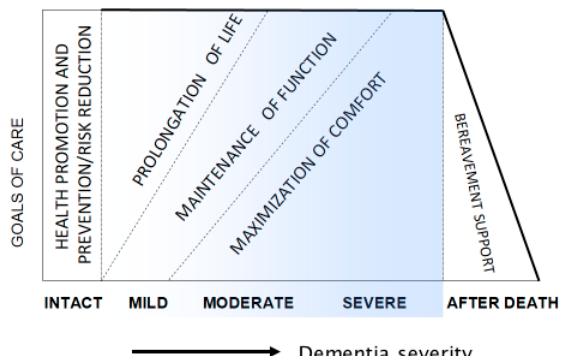
Figure 2. Dementia progression and prioritizing of care goals (reprinted with permission from van der Steen et al., Palliative Medicine 28(3), 197–209, 2014) [2].